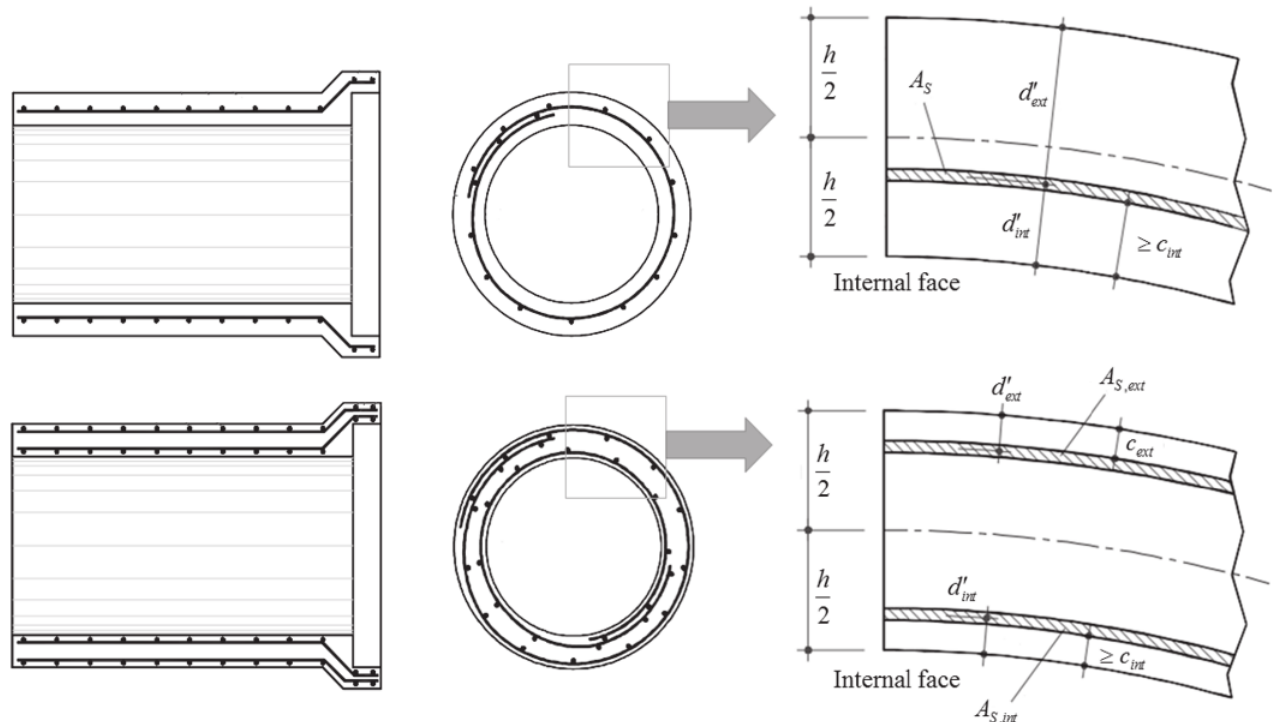
Reinforcement scheme (after